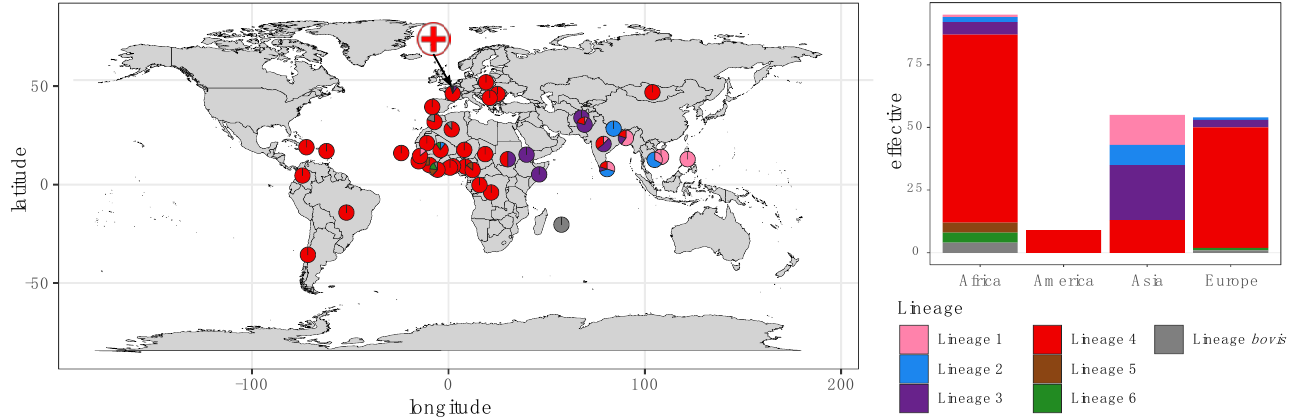
Figure 2. Global distribution of M. tuberculosis lineages by country of origin amongst the patients included in this study. Each color represents a distinct TB lineage. The symbol of a cross on the map represents the location of the Avicenne Hospital.